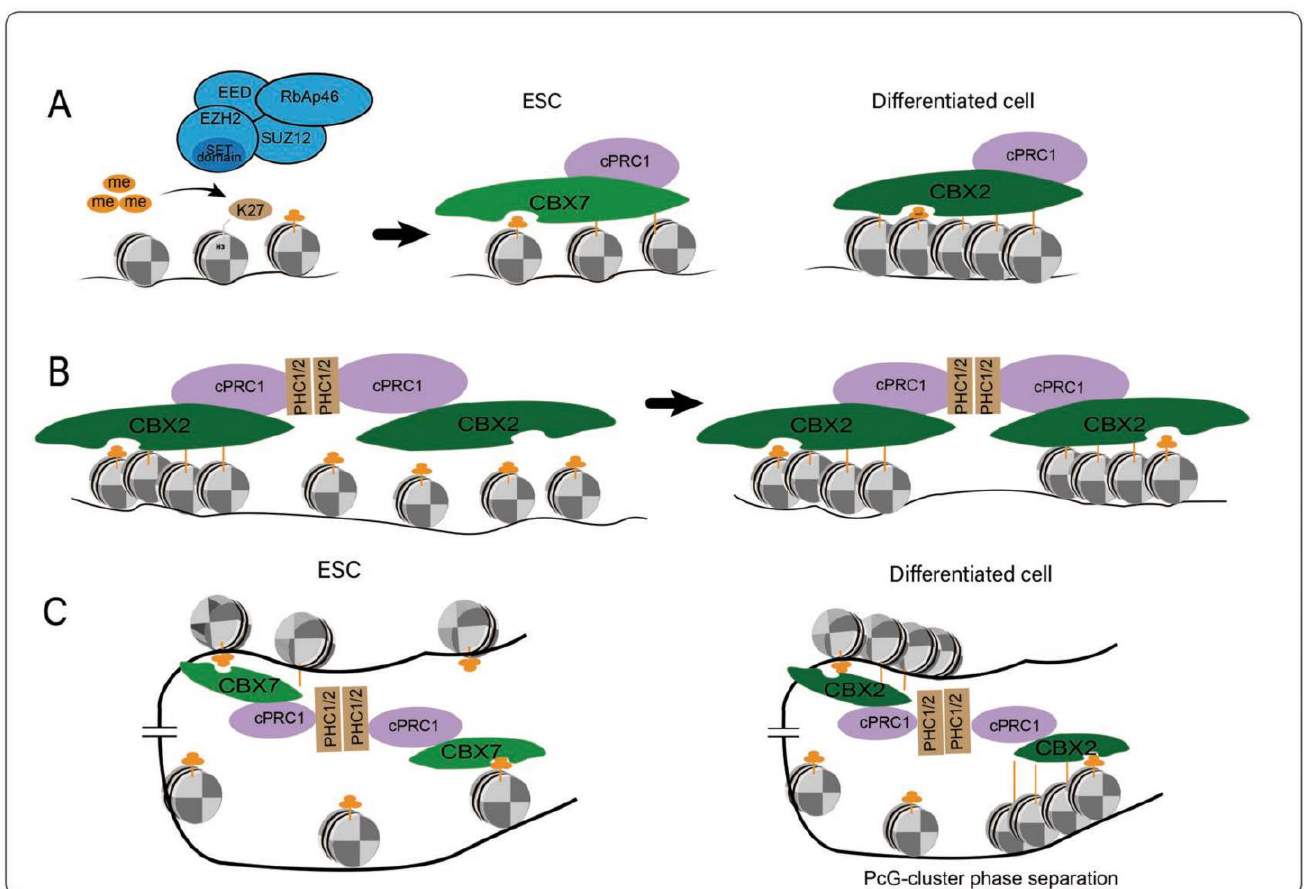
Figure 4. Mechanisms of establishment of long-distance chromatin interactions between distant genomic loci during differentiation of ESCs. ( A ) Depiction of PRC1 containing CBX7 in ESCs and CBX2 in differentiated cells. ( B ) Local compaction of chromatin by CBX2 in differentiated cells. ( C ) Spreading of PRC1 through long-distance contacts between distant genomic loci mediated by CBX7 and CBX2 subunits in ESCs and differentiated cells,